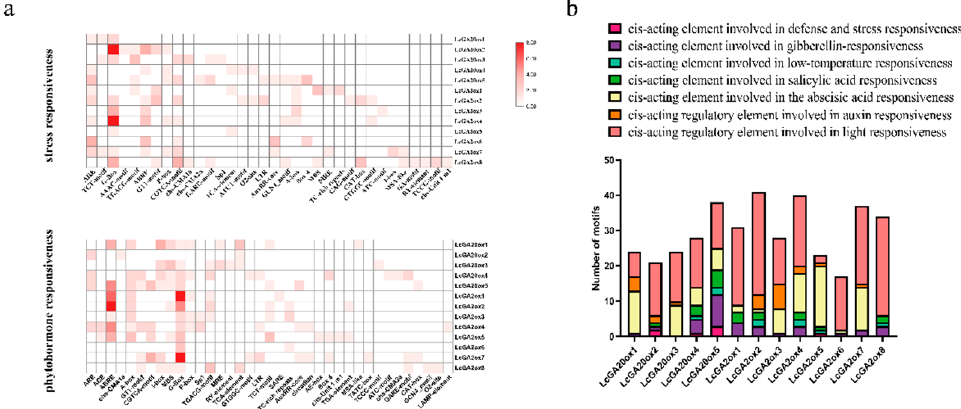
Figure 8. The number of cis-elements in LcGA20ox and LcGA2ox promoter. ( a ): The combine motifs about phyhormone and stress responsiveness in LcGA20ox and LcGA2ox gene families. The shade of the red represents the quantity. ( b ): The number of cis-elements about different hormone and abiotic stress in LcGA20ox and LcGA2ox gene families. Purple represents the gibberellin response element; Pink represents the light response element; Organ represents the auxin response element; Creamy yellow represents the abscisic acid response element; Green represents the salicylic acid response element; Light cyan represents the low-temperature response element; Purple represents the defense and stress response element.